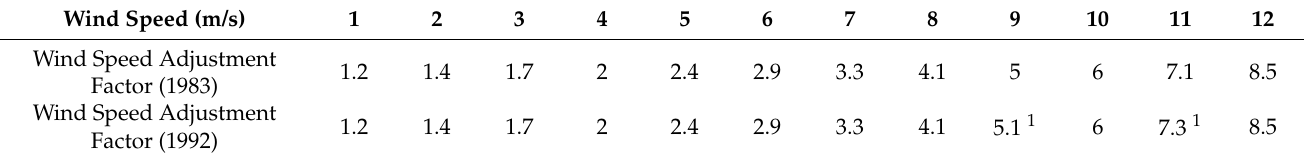
Table 1. Wind Speed Adjustment